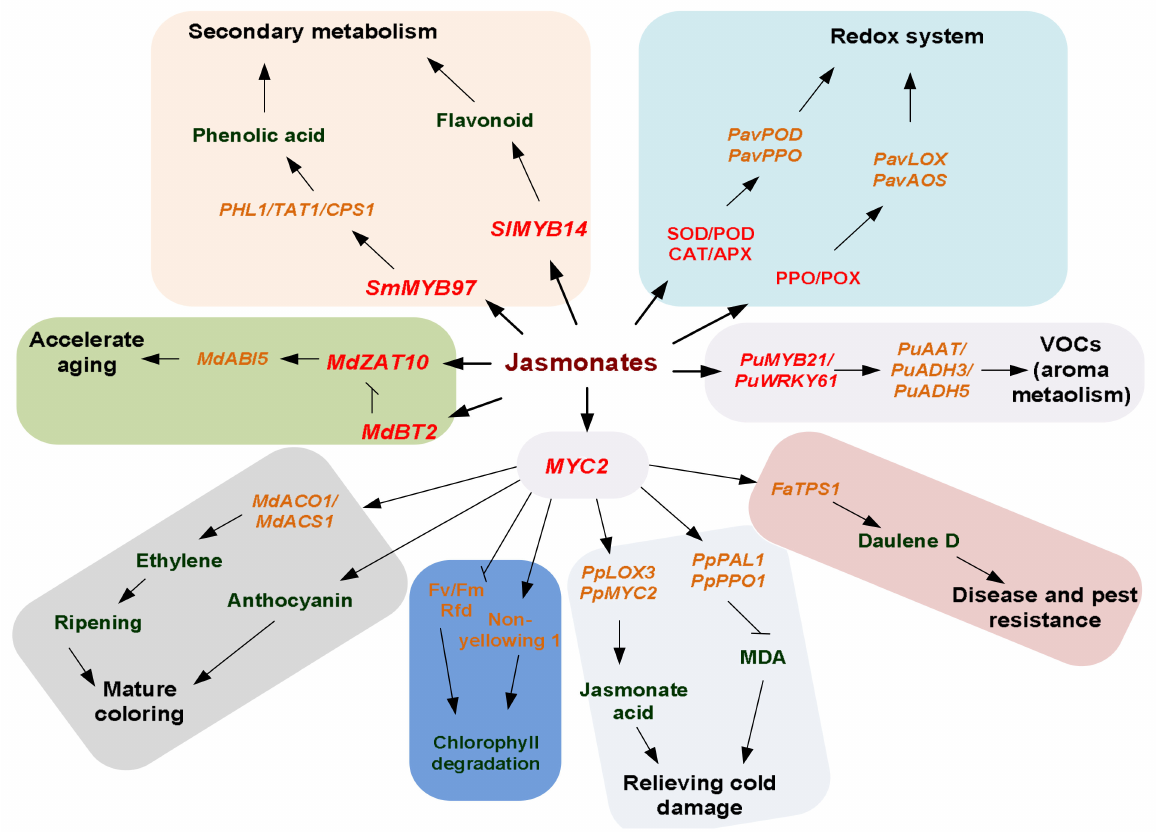
Figure 4. Biological functions of the jasmonate signaling pathway in agricultural crops. The biological functions of JAs mainly include the promotion of fruit ripening at the initial stage via ethylene- dependent and independent mechanisms, the regulation of mature coloring via regulating the degradation of chlorophyll and the metabolism of anthocyanin, and the improvement of aroma components via the regulation of fatty acid and aldehyde alcohol metabolism in agricultural crops. Additionally, JA signaling pathways enhanced stress resistance via the regulation of secondary metabolism and the redox system and alleviated cold damage in crops through improving the stability of the cell